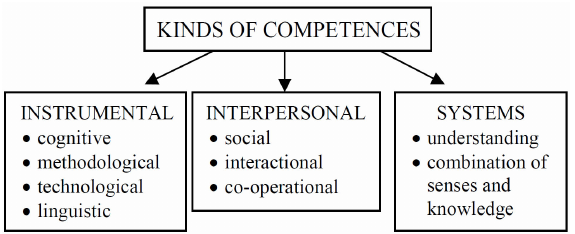
Figure 1. Kinds of Competences according to Tuning Educational Structure in Europe (2005)